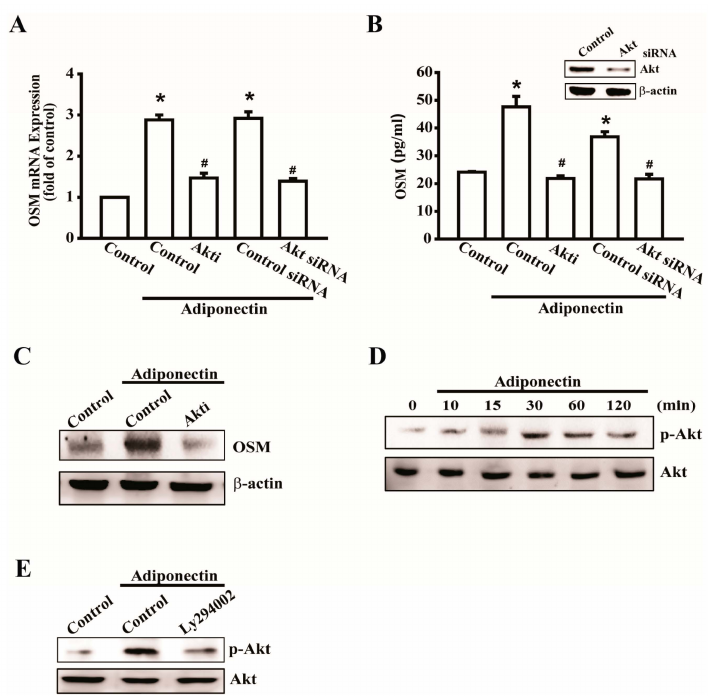
Figure 3. Involvement of Akt in adiponectin-induced OSM expression in osteoblasts. ( A ) Osteoblasts were pretreated with Akt inhibitors (Akti) (20 µ M) or transfected with Akt siRNA (0.5 nM) for 24 h followed by stimulation with adiponectin (100 ng/mL), OSM expression was measured by qPCR ( n = 6); ( B ) Cells were transfected with Akt siRNA (0.5 nM) for 24h, the protein level of Akt was measured by Western blot ( upper-panel ), and supernatant medium was collected to measure OSM expression by ELISA assay ( lower-panel ) ( n = 5); ( C ) Cells were pretreated with Akti (20 µ M) for 30 min followed by stimulation with adiponectin (100 ng/mL), the protein level of OSM was measured by Western blot ( n = 5); ( D ) Osteoblasts were incubated with adiponectin (100 ng/mL) in time intervals, and phosphate-PI3K expression was investigated by Western blot ( n = 4); ( E ) Cells were pretreated with PI3K inhibitor, LY294002 (10 µ M), for 30 min followed by stimulation with adiponectin (100 ng/mL), phosphate-Akt expression was investigated by Western blot ( n = 5). Results are expressed as mean ˘ S.E.M. *, p < 0.05 compared with control; # , p < 0.05 compared with adiponectin-treated